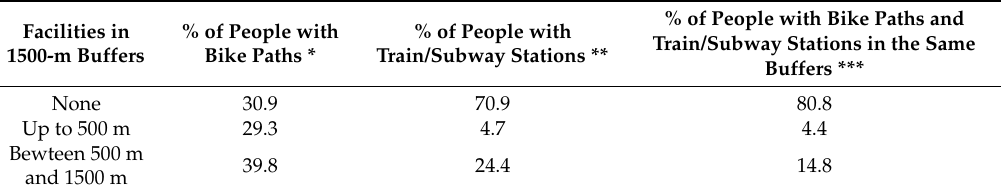
Table 3. Results of the multilevel model for the association between cycling for transportation with bike paths and train or subway stations.